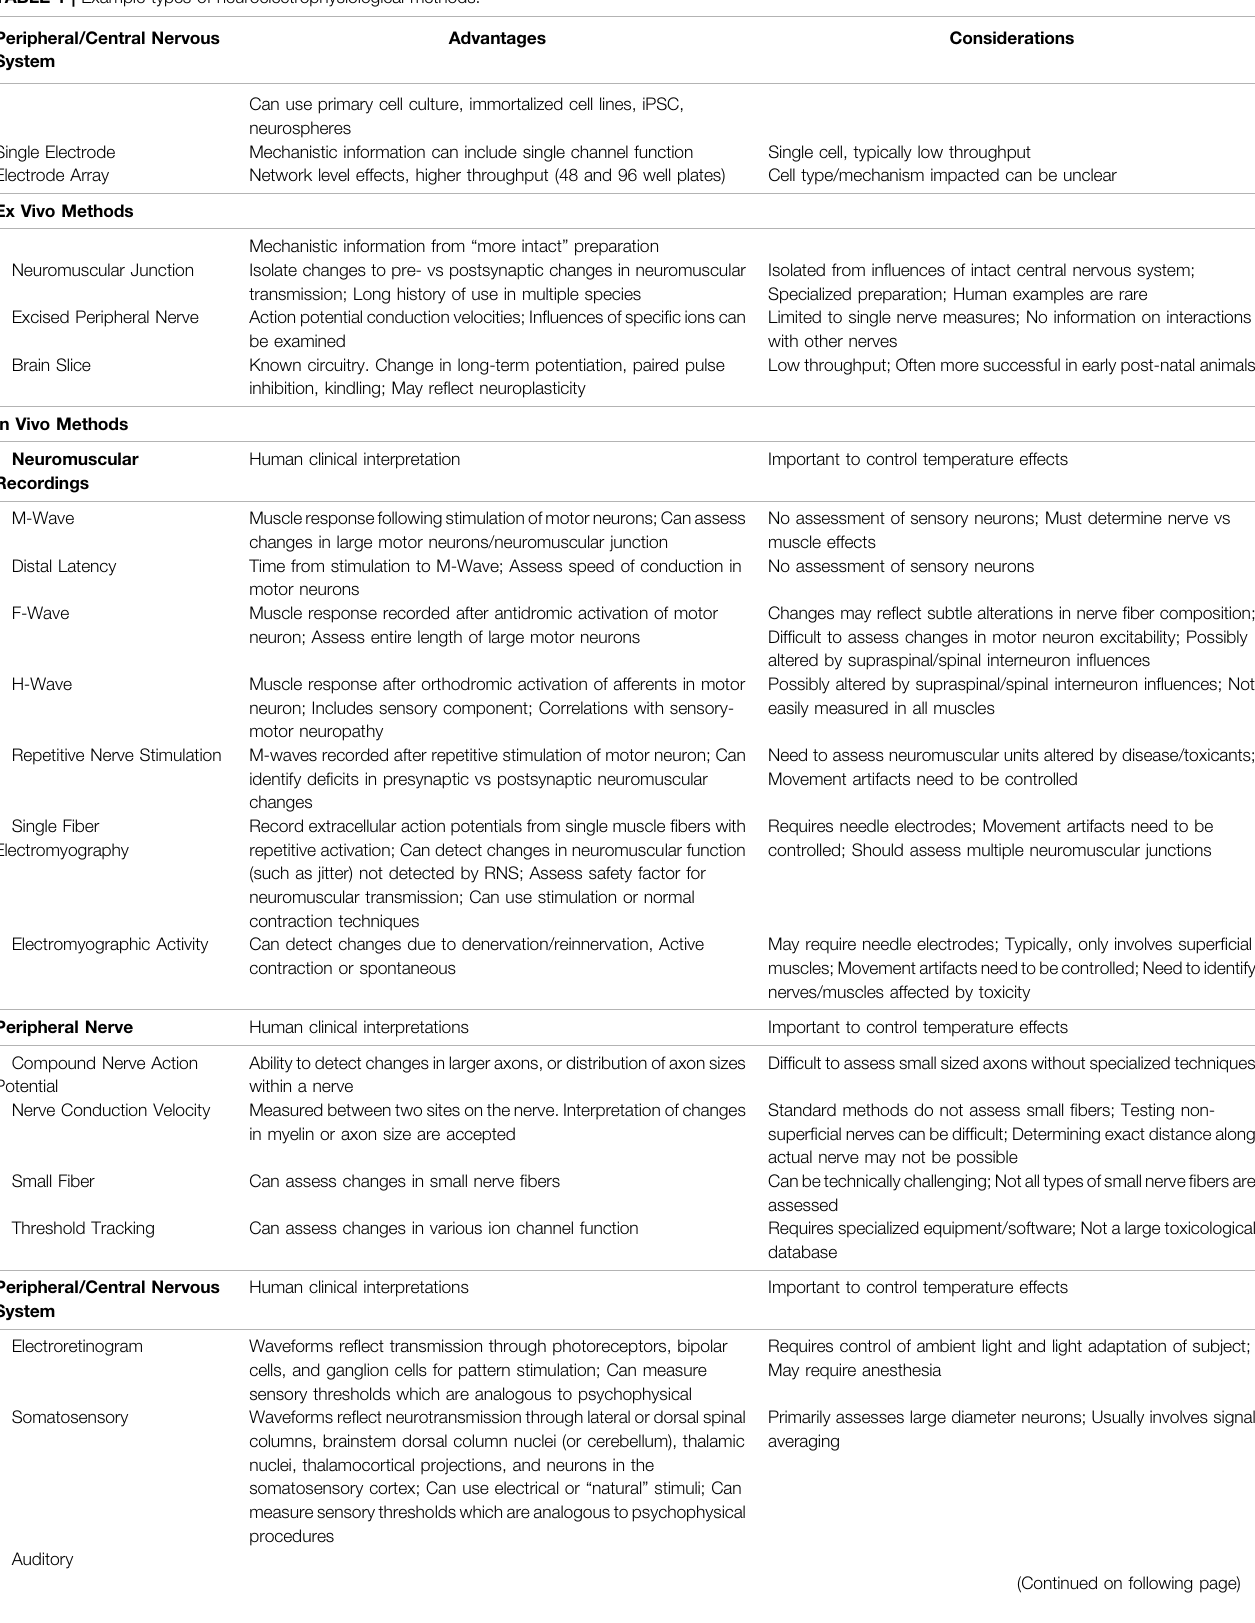
TABLE 1 | Example types of neuroelectrophysiological